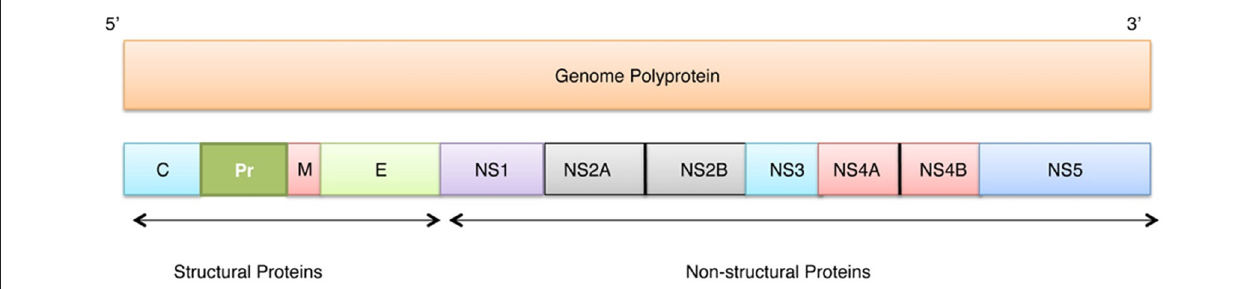
FIGURE 1 | Localization of individual proteins within the genome polyprotein of Zika virus (Q32ZE1). Top bar shows ZIKV RNA (10974 bases) that translates into polyprotein of 3418 residues (bottom bar) that at maturation is cleaved into three structural proteins (Capsid (C), Precursor membrane (prM), and Envelope protein (E)) and seven non-structural proteins (NS1, NS2A, NS2B, NS3, NS4A, NS4B,